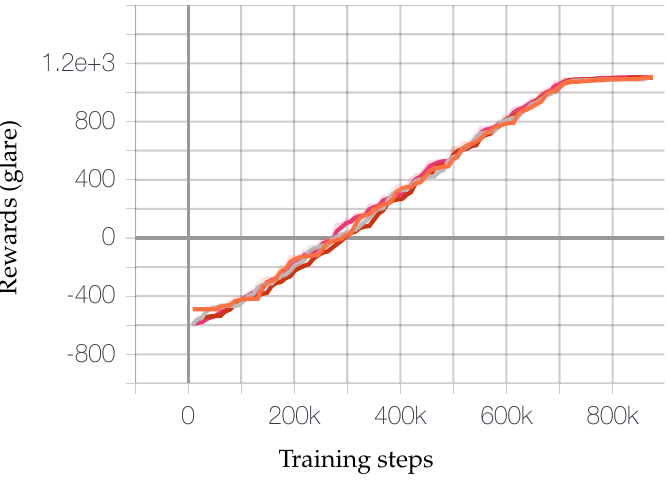
Figure 7. Top jobs achieving rewards (glare) over the training duration. Table 4. Best configurations and their corresponding maximum